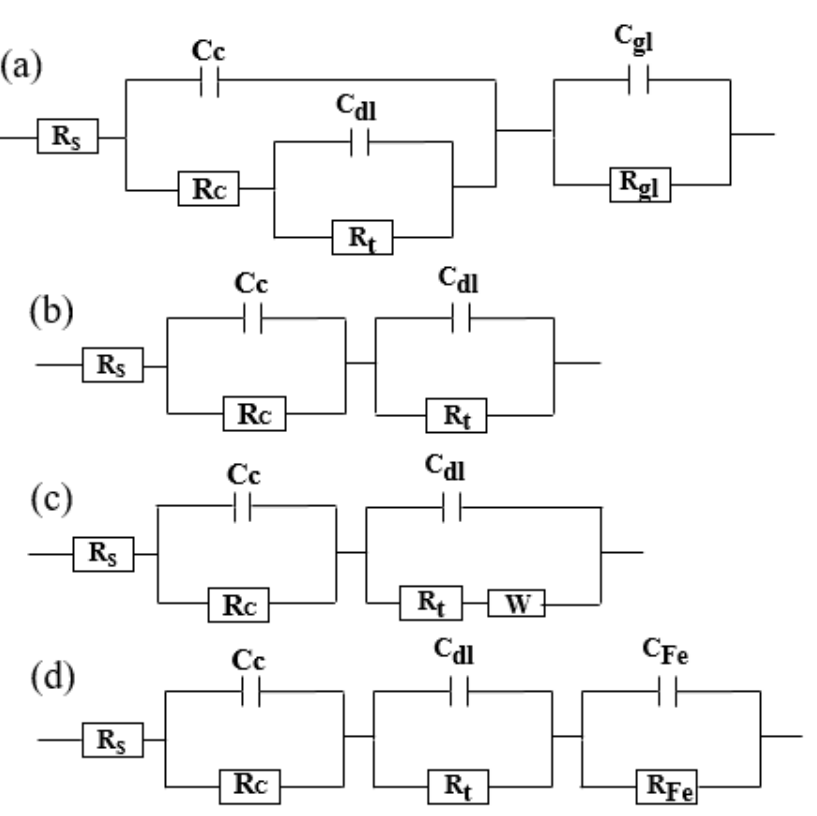
Figure 10. The corresponding equivalent circuits for electrochemical behavior of CGC and CPTES/CGC in different time; ( a ): 0–24 h for CGC, 0–72 h for CPTES/CGC; ( b ):24–504 h for CGC, 72–2736 h for CPTES/CGC; ( c ): 504–840 h for CGC, after 2736 h for CPTES/CGC; and ( d ): after 840 h for CGC.